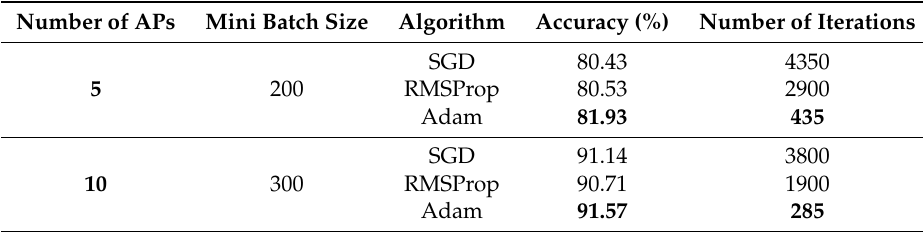
Table 4. Variation of the accuracy according to the optimization algorithm on the validation data using a grid of size 2 m × 2